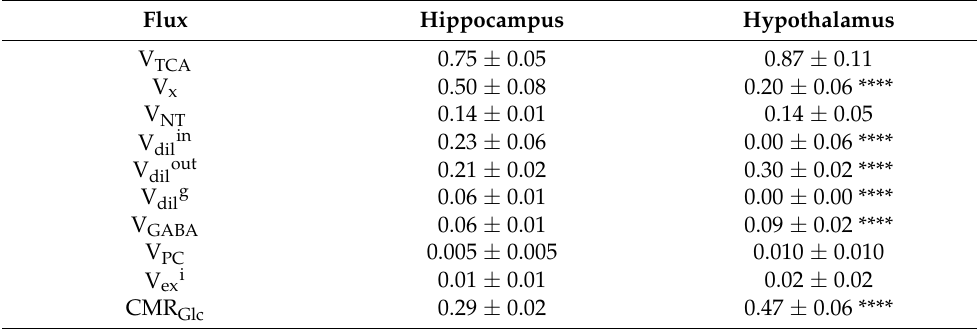
Figure 3. Mathematical 1-compartment model of brain metabolism assessed with [1,6- 13 C 2 ]Glc. La- beled and non-labeled glucose (Glc) is metabolized to pyruvate (Pyr) in the brain, which corresponds to the cerebral metabolic rate of glucose (CMR Glc ). Pyruvate, in fast exchange with lactate (Lac), can either exchange with blood lactate (via V dilin or V dilout ), be carboxylated into oxaloacetate (OAA) in glial cells (via V PC ) or enter mitochondrial tricarboxylic acid (TCA) cycle (via V TCA ). Dilution can occur in the acetyl-CoA (AcCoA) pool produced from pyruvate, by exchange with ketone bodies, acetate (Ace) or glial-specific metabolism (via V dilg ). Transamination in the mitochondria (V x ) lead to the exchange of labeling from OAA and oxoglutarate (OG) with aspartate (Asp) and glutamate (Glu) respectively. Glu labels glutamine (Gln) through the neurotransmitter cycling flux (V NT ), and the excess Gln is released in the blood (V eff ) to maintain anaplerotic balance. In inhibitory neurons, Glu-GABA flux (V GABA ) corresponds to the synthesis of GABA from Glu and its recycling into the TCA cycle. Due to potential compartmentation of GABA metabolic pools, an exchange flux can occur, leading to GABA labeling dilution (V exi ). Table 1. Summary of hippocampal and hypothalamic metabolic fluxes assessed with a 1-compartment model of brain